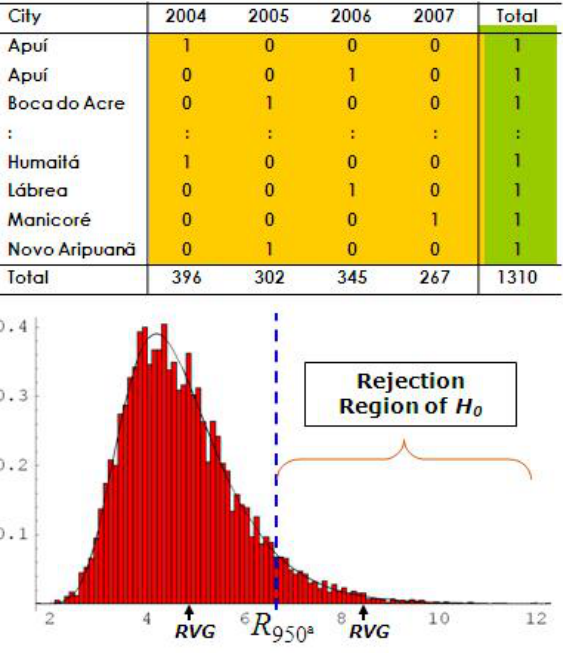
Figure 4. Monte Carlo procedure